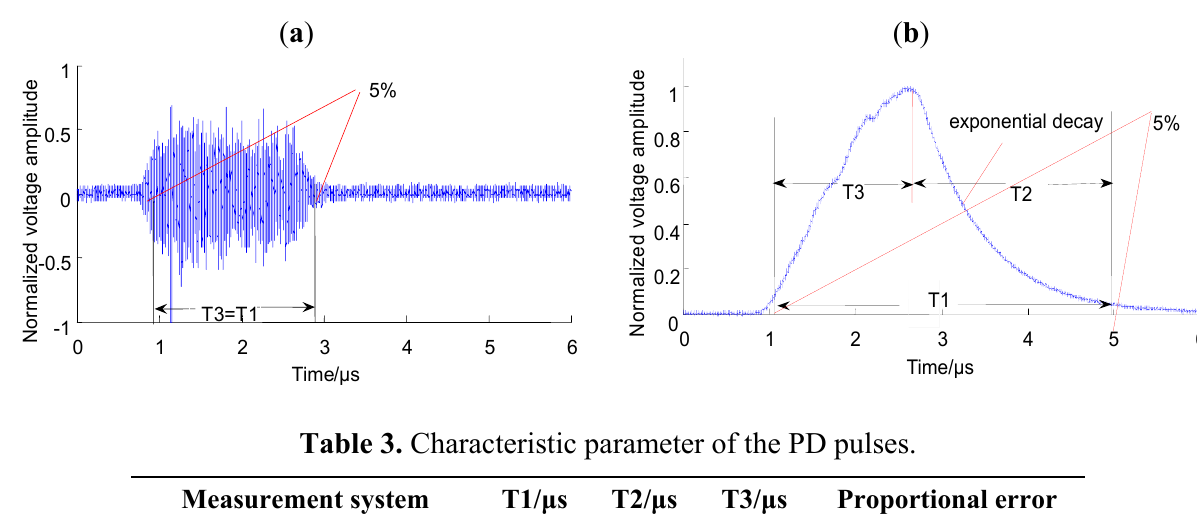
Figure 7. PD signals detected using the two methods: ( a ) PD signal detected by a UHF sensor; ( b ) PD signal detected by a fluorescent fiber sensor.